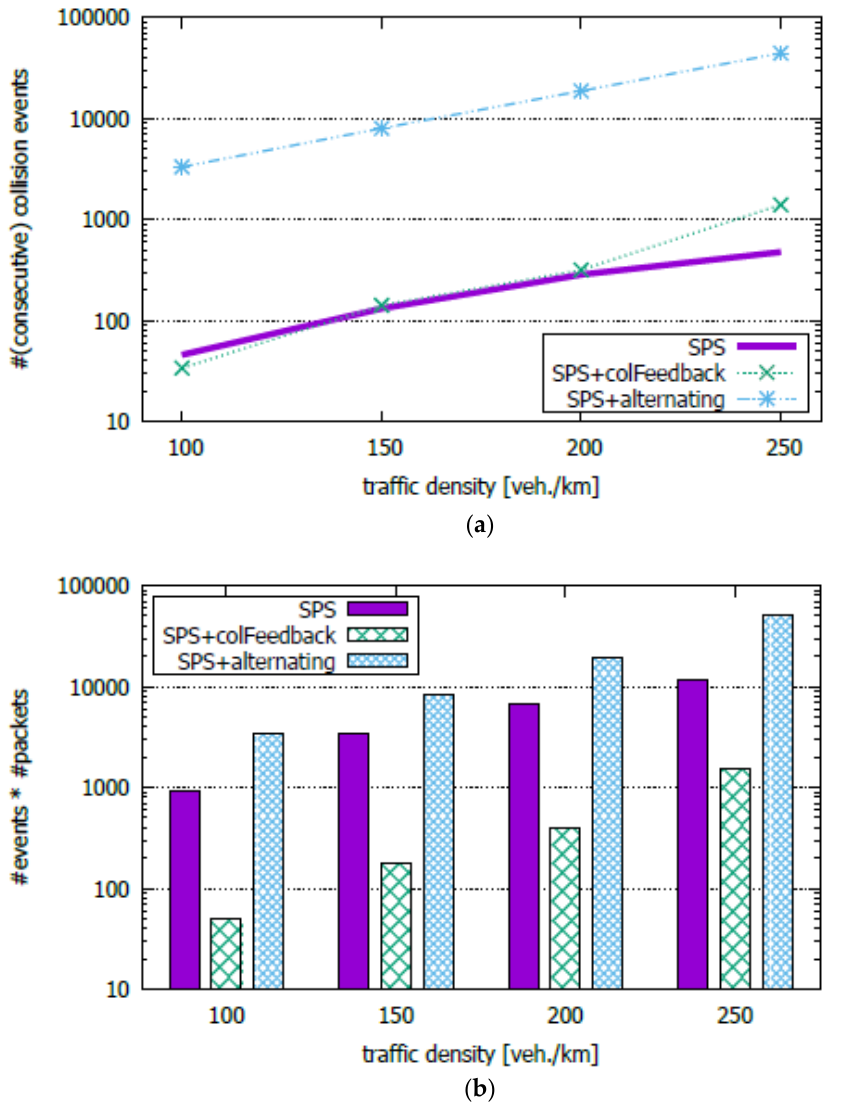
Figure 9. Performance comparison: ( a ) number of consecutive collision events; ( b ) number of individual collisions, y-axis in log scale.